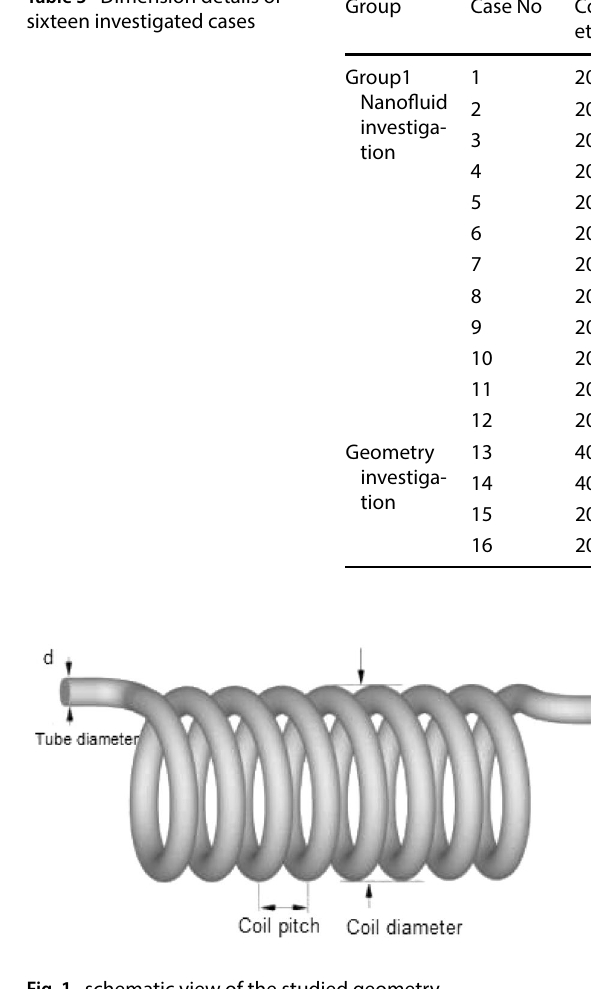
Fig. 1 schematic view of the studied geometry